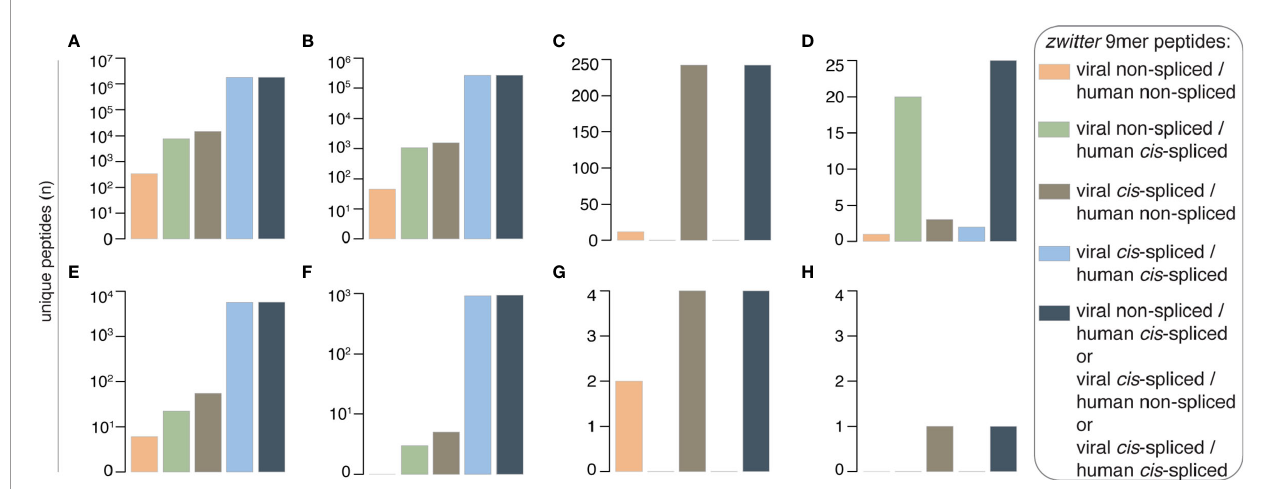
FIGURE 2 | Theoretical viral-human zwitter 9mer peptide frequency and potential association with T1D. (A – H) Number of theoretical viral-human 9mer (non-spliced or cis -spliced) (A) zwitter peptides, (B) zwitter epitope candidates predicted to ef fi ciently bind selected HLA-I complexes, (C) zwitter epitope candidates described in published HLA-I immunopeptidomes, (D) zwitter epitope candidates that showed a positive T cell response in published studies, (E) zwitter epitope candidates derived from T1D-associated antigens, (F) zwitter epitope candidates predicted to ef fi ciently bind selected HLA-I complexes and derived from T1D-associated antigens, (G) zwitter epitope candidates described in published HLA-I immunopeptidomes and derived from T1D-associated antigens, (H) zwitter epitope candidates that may be derived from T1D-associated antigens and showed a positive T cell response in published studies. For the identi fi cation of epitope candidates already identi fi ed in HLA-I immunopeptidomics or analyzed (with positive outcome) for T cell recognition, we consulted the IEDB